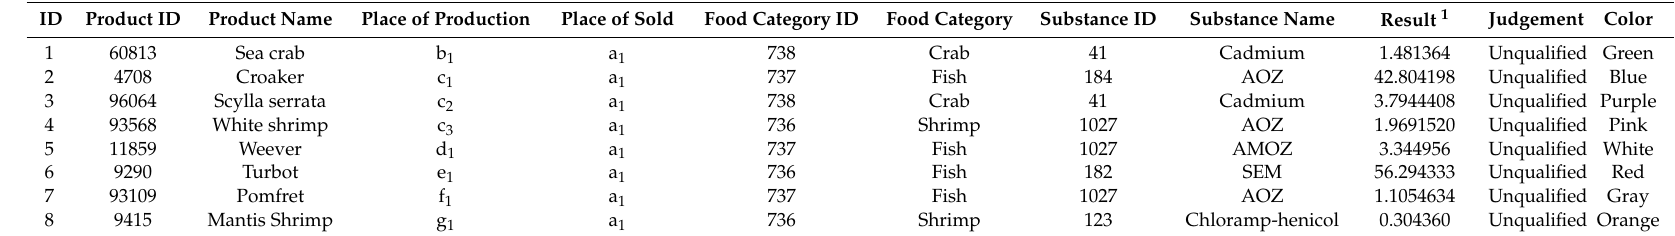
Table 2. Parameters of the unqualified